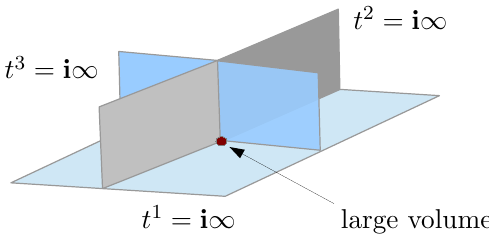
Figure 8 . The large volume point arises on the discriminant locus of the K(cid:127)ahler moduli space at the intersection of h 1 ; 1 ( ~ Y 3 ) = 3 divisors t I = i 1